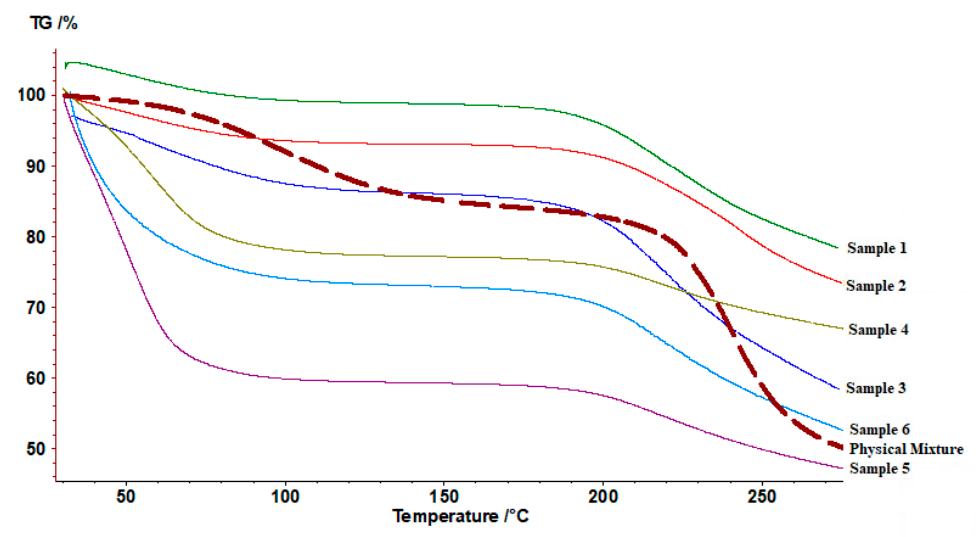
Figure 4. Thermogravimetric thermograms of prepared samples 1, 2, 3, 4, 5, 6, and the corresponding physical